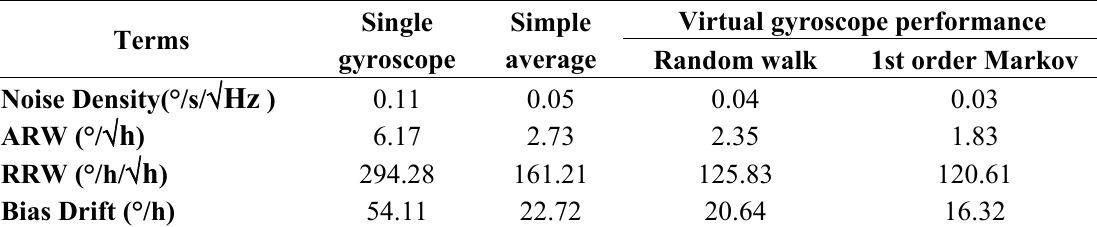
Table 2. Static test results of the virtual